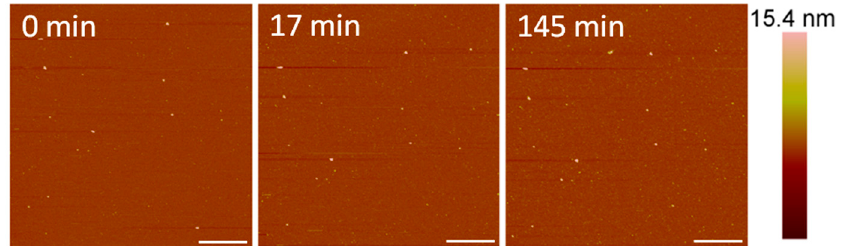
Figure 7 . AFM image of a supported PC membrane exposed to 1 µM indolicidin. The scale bars represent a distance of 1 µm.